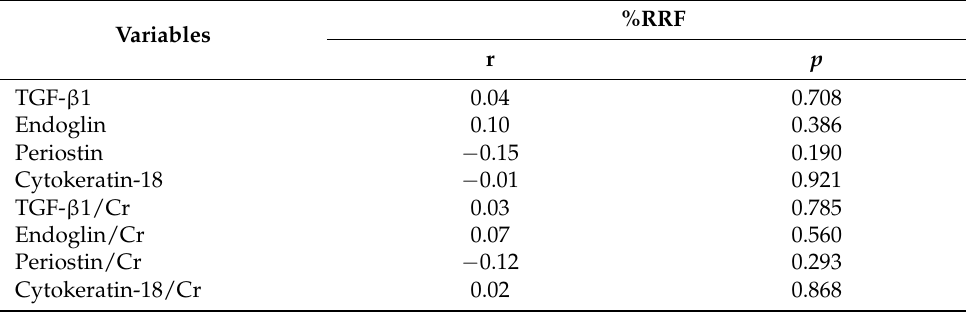
Table 3. Correlations between urinary biomarkers and %RRF in the study group.